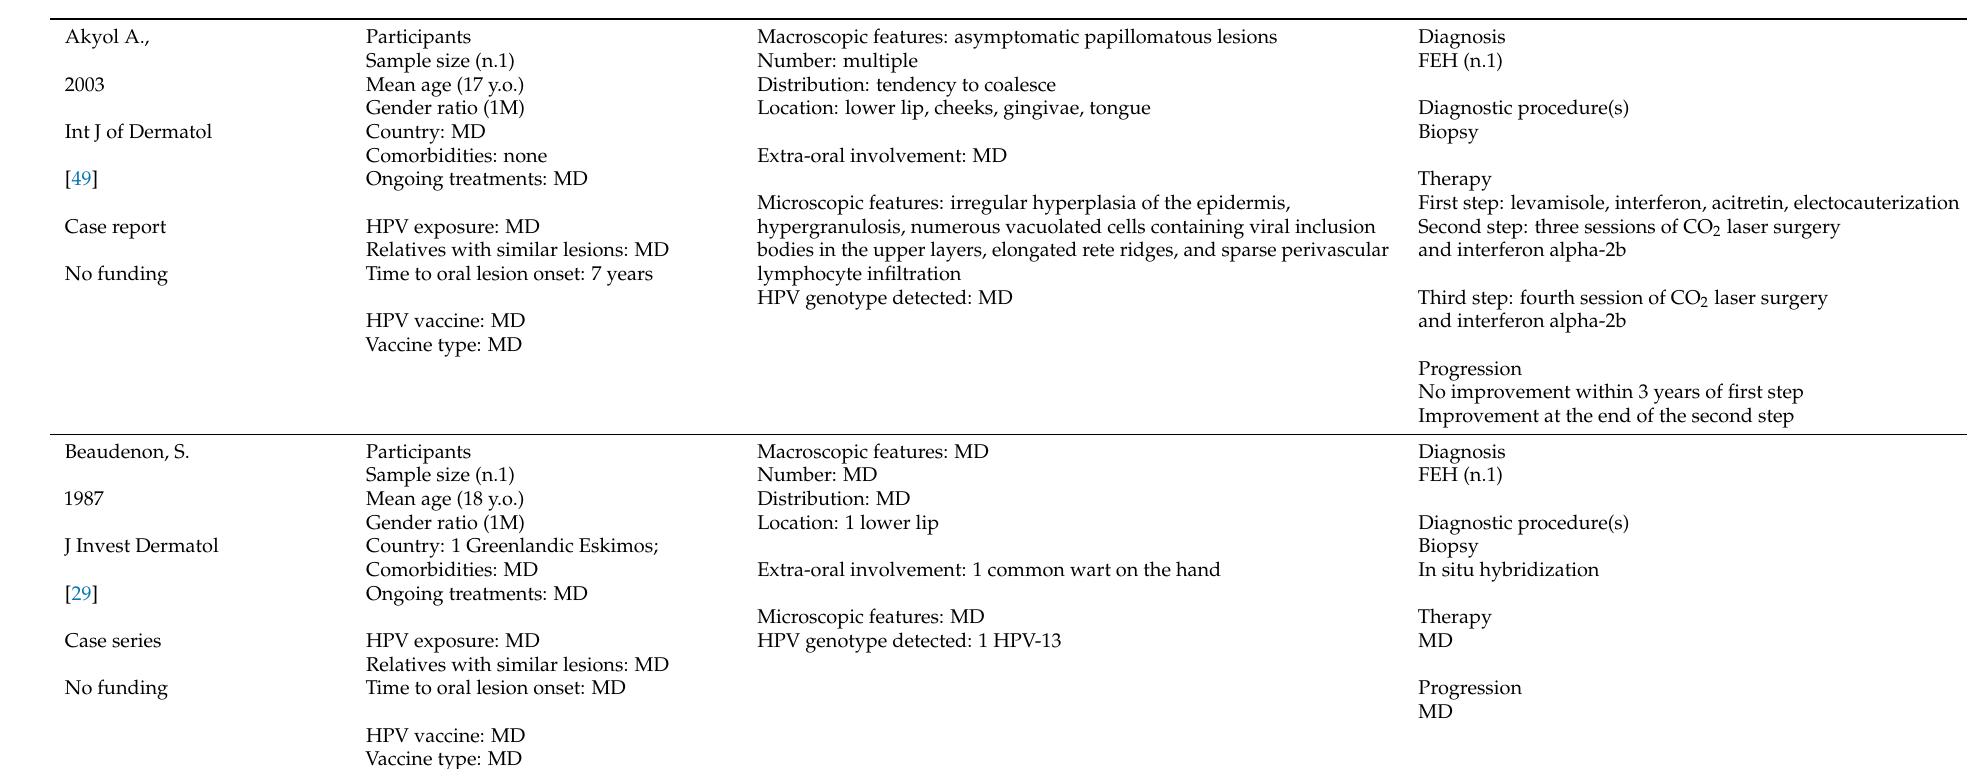
Table 2. Extracted and collected data from studies reporting pediatric cases diagnosed with oral focal epithelial hyperplasia. Study characteristics: first author, year, and journal of publication; study design; the reference number; funding. Study methods: sample size (n.), mean age (y.o.), gender ratio (M/F), country, comorbidities and associated ongoing treatments, relatives with similar lesions, HPV exposure (if any), time to onset of oral lesions, type of HPV vaccine administered (if any). Oral HPV-related lesions: macroscopic and microscopic features, number (single/multiple), distribution (unilateral/bilateral, asymmetric or symmetric), location, extra-oral involvement, HPV genotype. Diagnosis: definitive diagnosis, diagnostic procedure(s) performed, therapy,